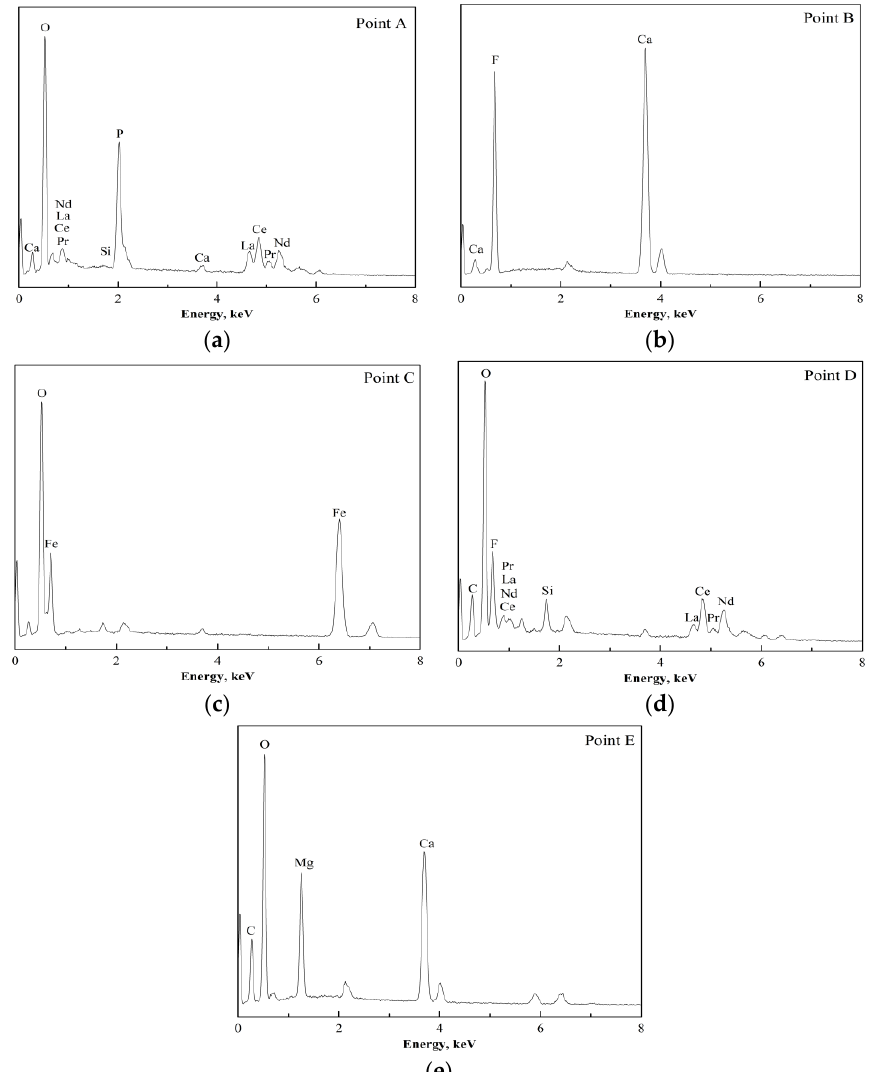
Figure 7. Energy dispersive X-ray spectroscopy (EDS) results for the mineralogical phases in Bayan Obo tailings: ( a ) Monazite; ( b ) Fluorite; ( c ) Hematite; ( d ) Bastnaesite; ( e ) Dolomite.